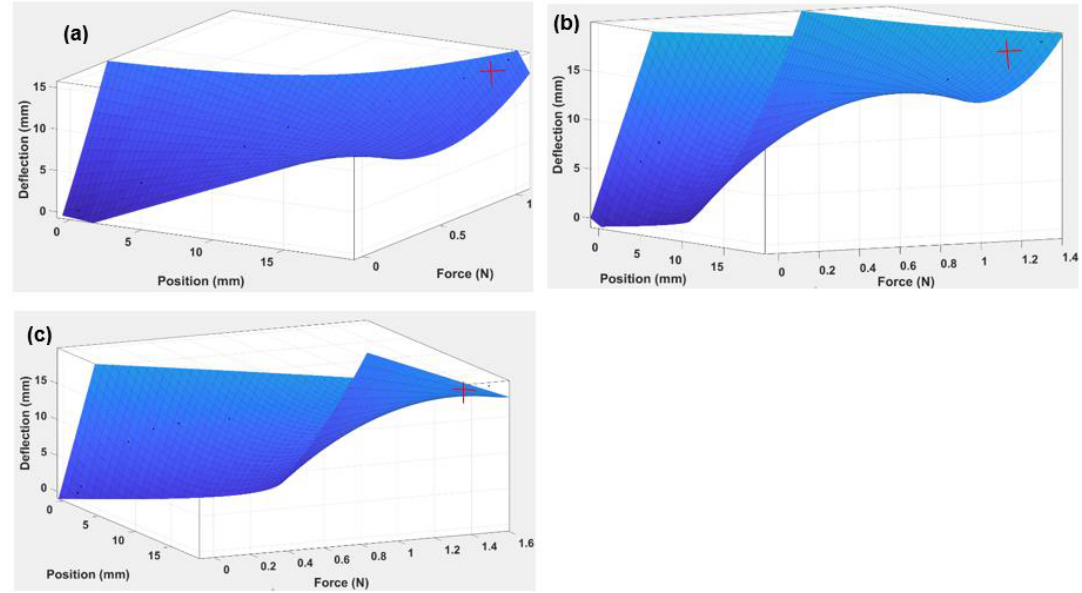
Figure 15. Three-dimensional gradient graph of TPU capsule “cross” showing relationship between Force (N), Position (mm), and Deflection (mm) for three beam thicknesses ( a ) 1.0 mm, ( b ) 2.0 mm, ( c ) 3.0 mm.